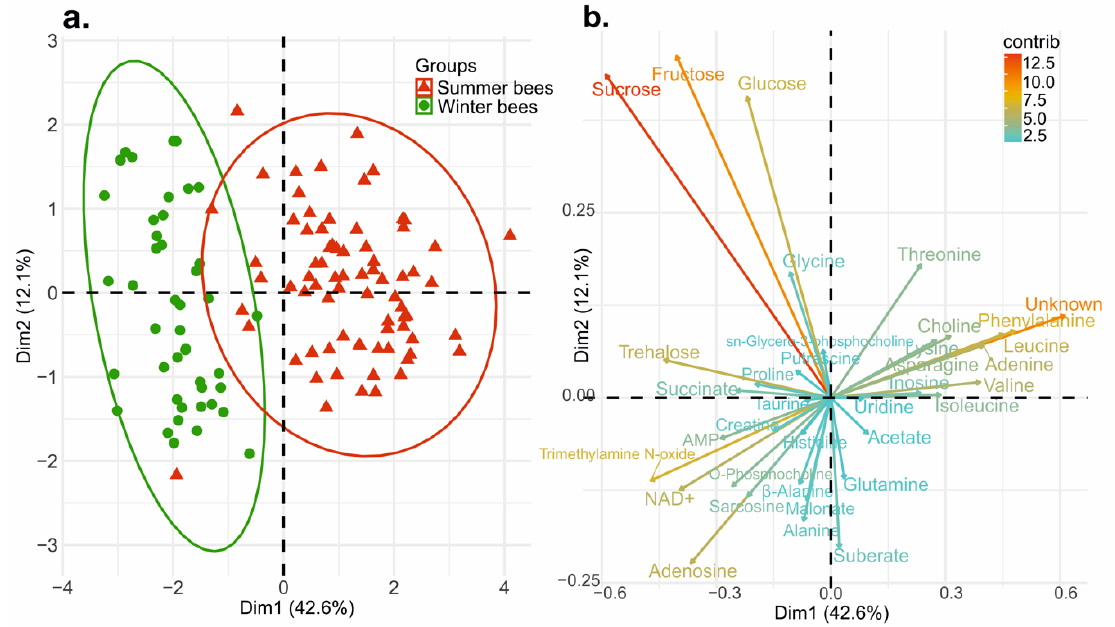
Figure 2. Principal component analysis of summer and winter bees ( a ) Score plot. Dim1(PC1) on the x -axis explains 42.6%, Dim2 (PC2) on the y -axis explains 12.1% of variability between the summer bees and winter bees; ( b ) Variable correlation plot. The length and colors of the arrows explain how each variable expresses the differences between the two compared groups (summer and winter).